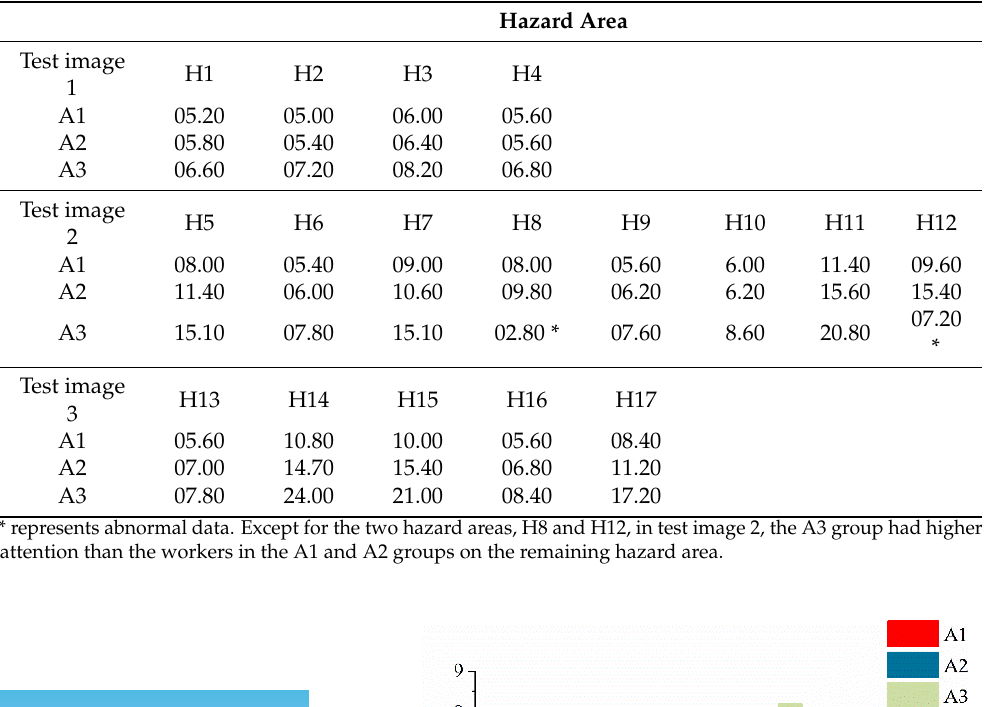
Table 7. The mean fixation count of three groups at each hazard area.